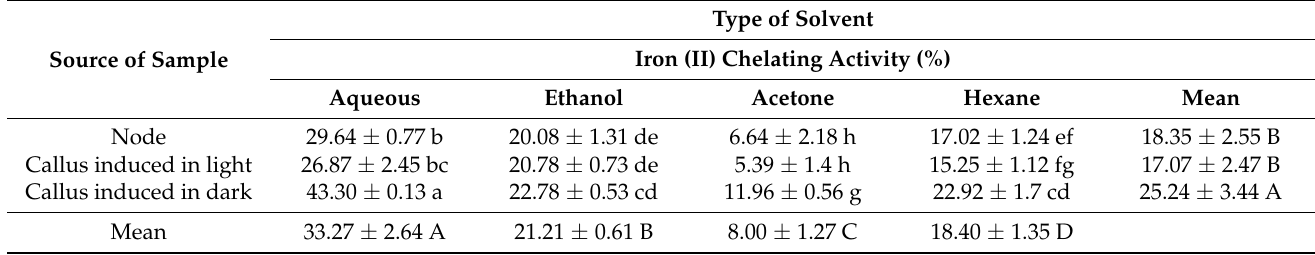
Table 5. Iron (II) chelating activity of node and in vitro-derived calli of Bougainvillea glabra